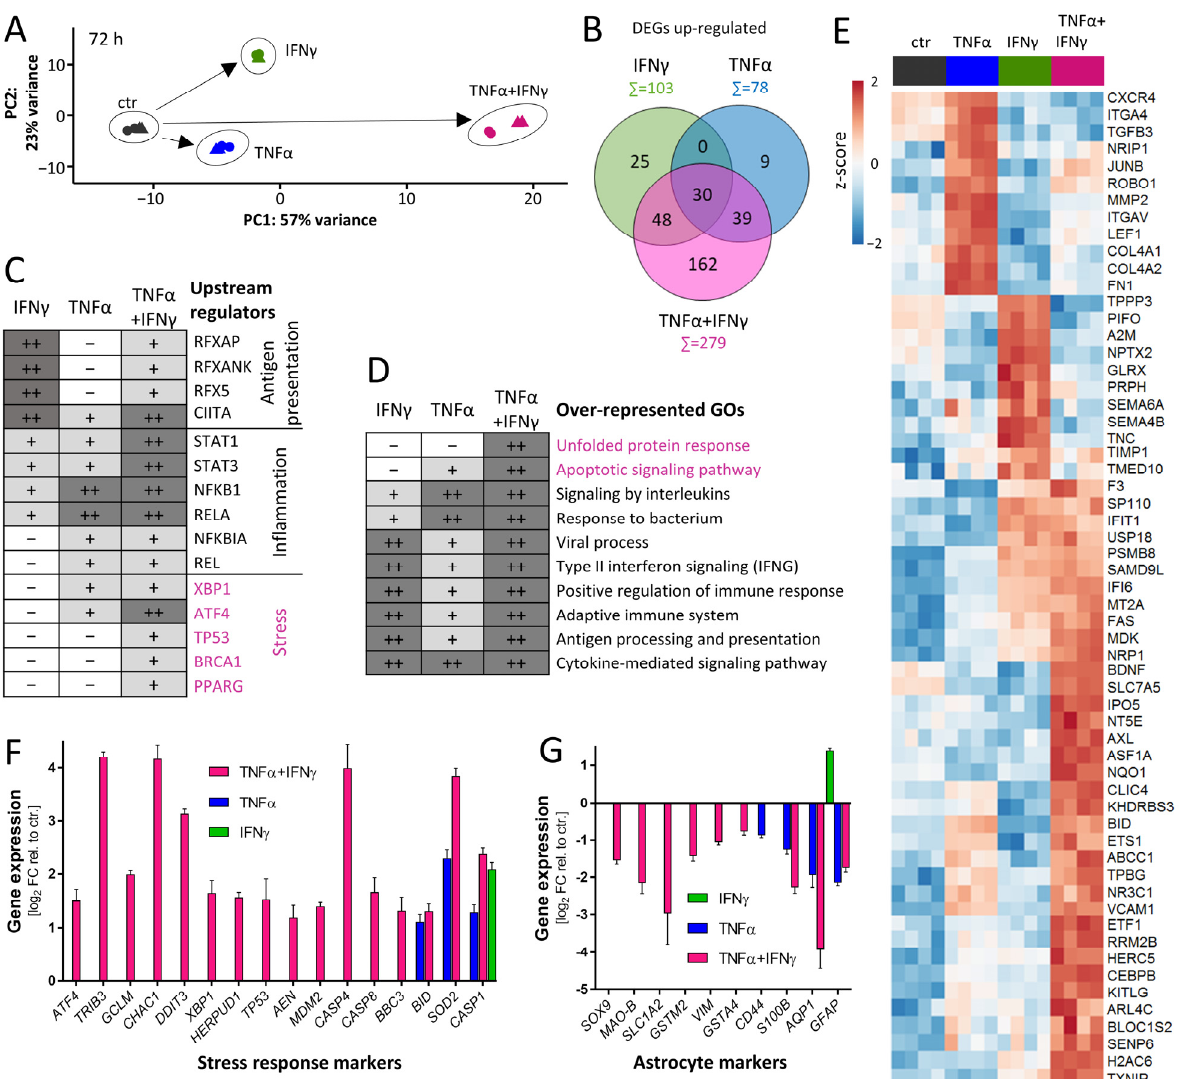
Figure 7. Characterization of response features of ACs after prolonged cytokine exposure. AC tran- scriptome data were obtained as detailed in Figure 4. Data analysis was focused on the 72 h time